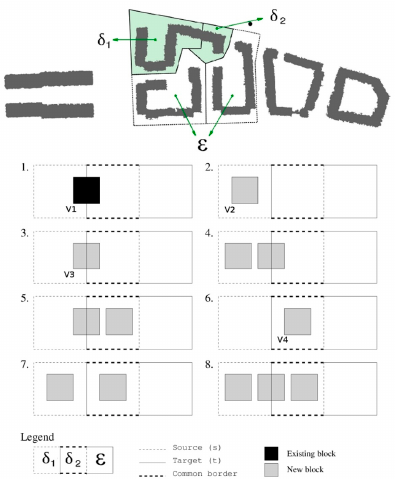
Figure 7. Sensitivity analysis performed using blocks (V1, V2, V3 and V4) changing block height.